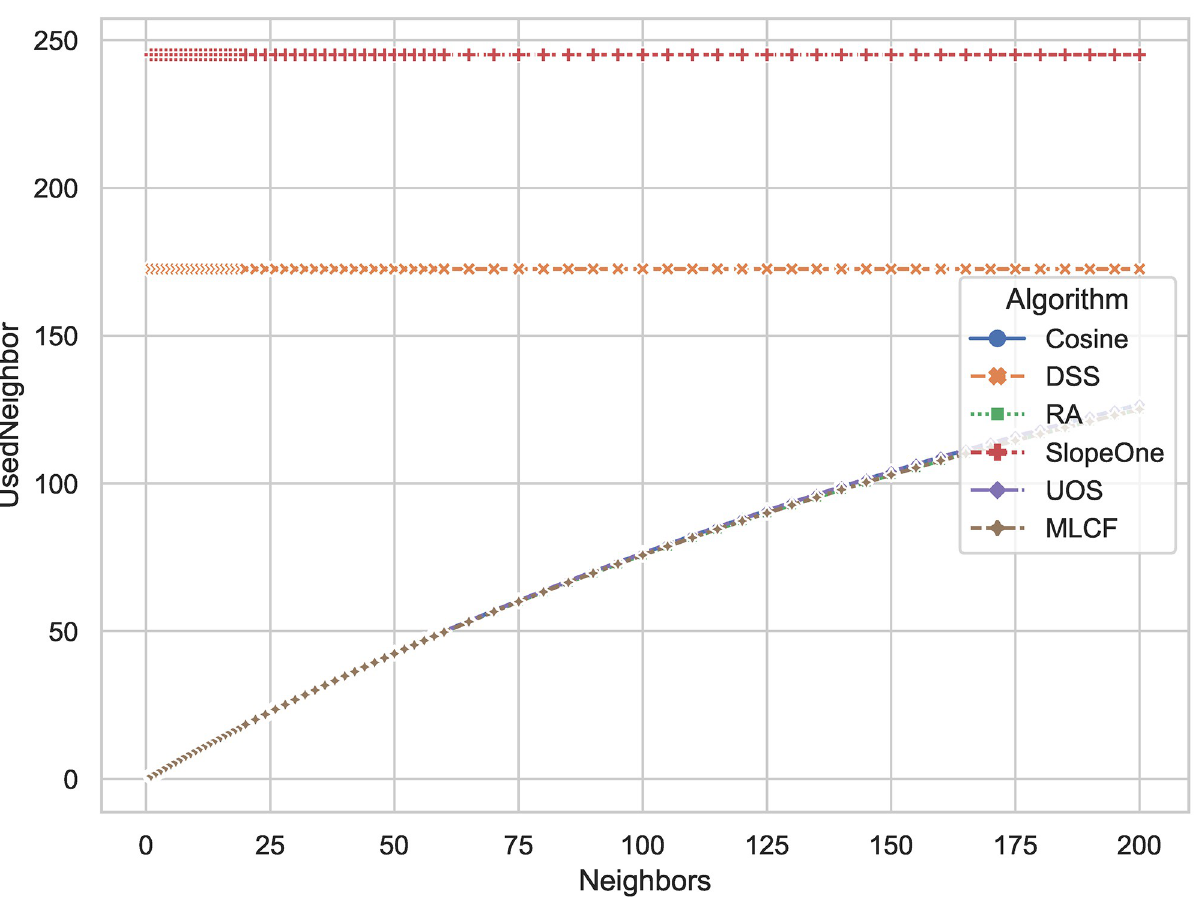
Fig 12. The actual number of neighbors used in prediction (y-axis) against the number of neighbors that algorithms plan to select (x-axis). The number of users selected for experiments is 3000.